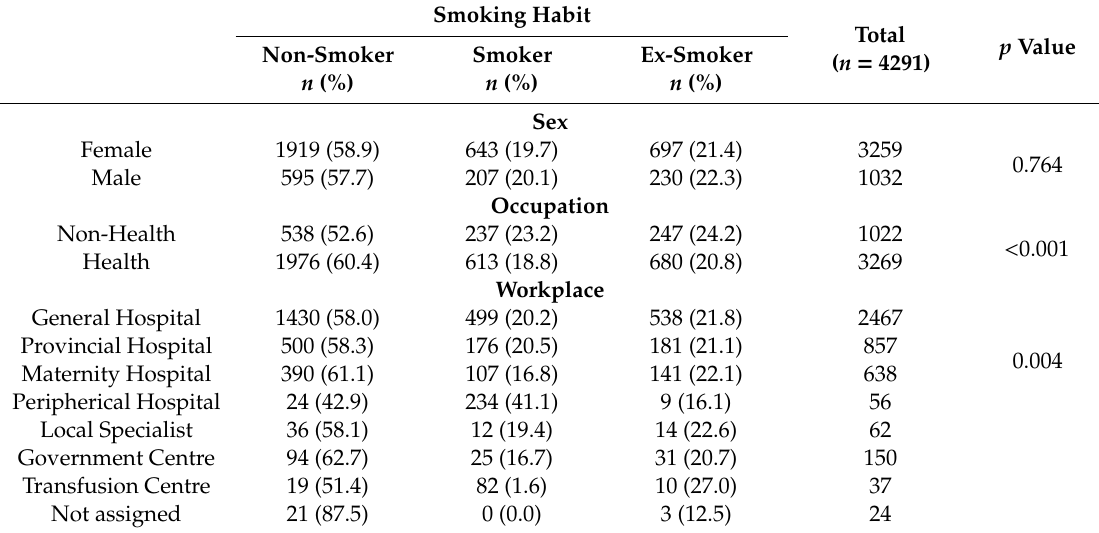
Table 2. Smoking habit according to sex, occupation, and workplace in the 2020 sample analysed.